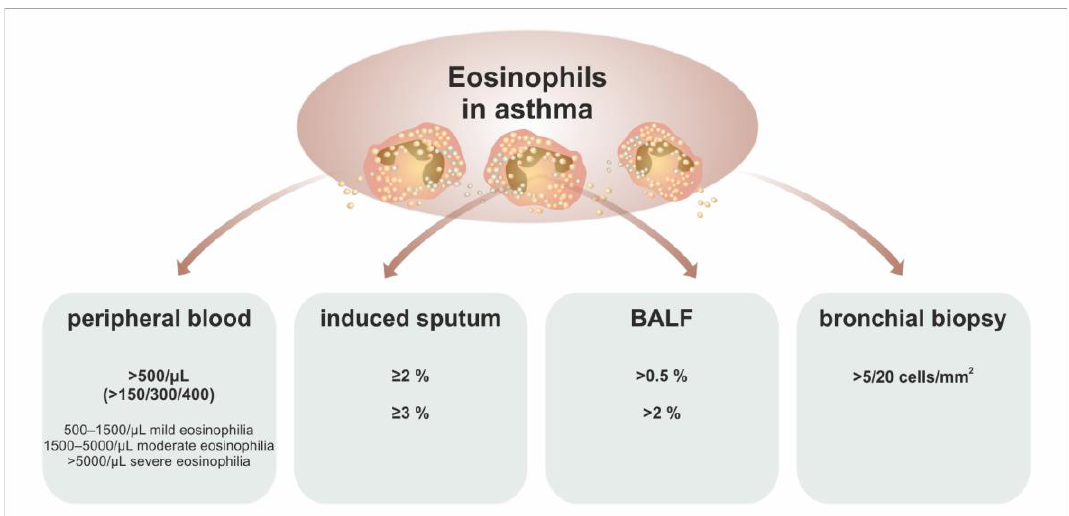
Figure 7. Evaluation of eosinophils and cut-off levels for different biological materials. The presence of eosinophils in various biological samples collected from asthma patients represents a critical characteristic for the definition of type 2-high (or eosinophilic) inflammation. However, the cut-off levels in most of these materials are not unified across the literature. In the peripheral blood, the normal AEC is 500 cells/ μL . However, according to the results of clinical studies, much lower counts (150/300/400) are associated with the clinical efficacy of antieosinophil therapy. In the induced sputum, the most commonly cited cut-off level is 2 – 3%, and in BALF, it is 0.5 – 2% of all analyzed cells. In bronchial biopsy samples, there is a wide range of cut-off levels in the literature (5–20 cells/mm 2 ). Different levels of method validation or standardization may cause these differences.